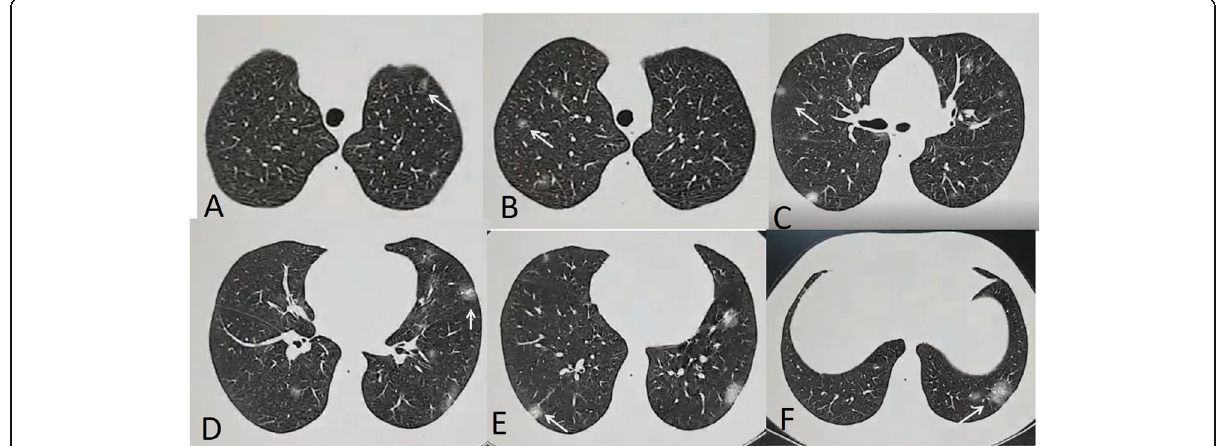
Fig. 8 A 32-year-old male with mild involvement of 5 lobes. Multiple nodular opacities with ground glass halo (white arrows). Total severity score =